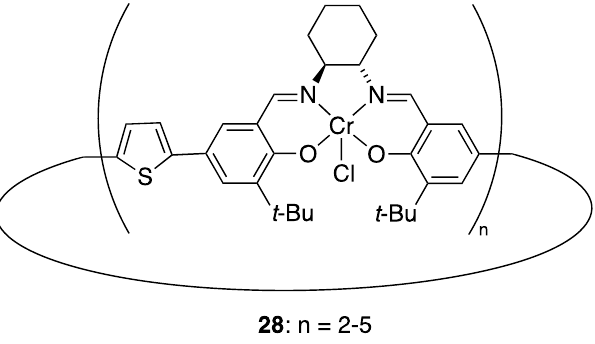
Figure 9. Macrocyclic calixsalen catalyst 28 .